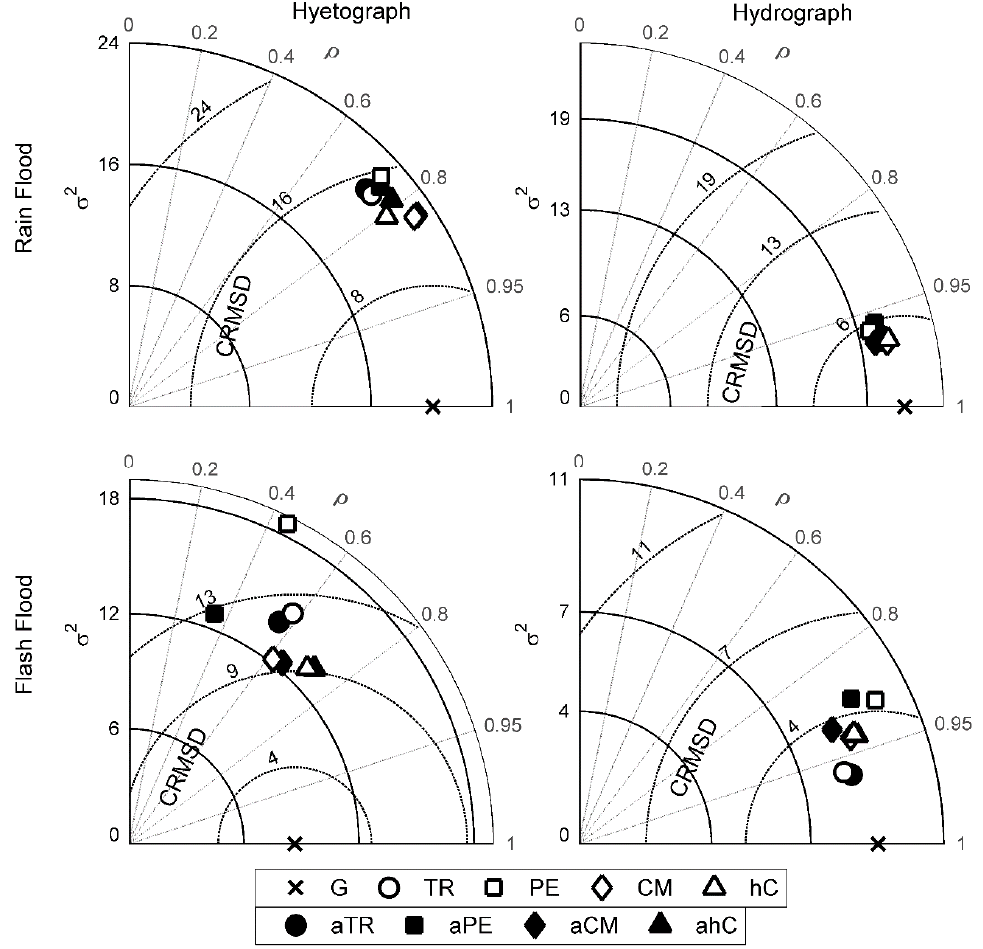
Figure 4. Same as in Figure 3, but for the event centroid.